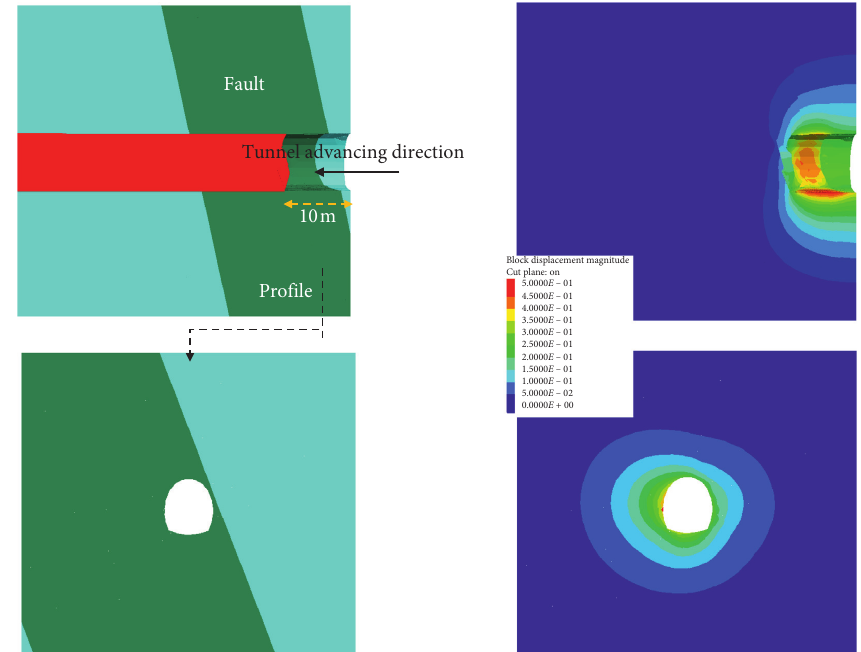
Figure 4: The range of tunnel entering fault is 10m.